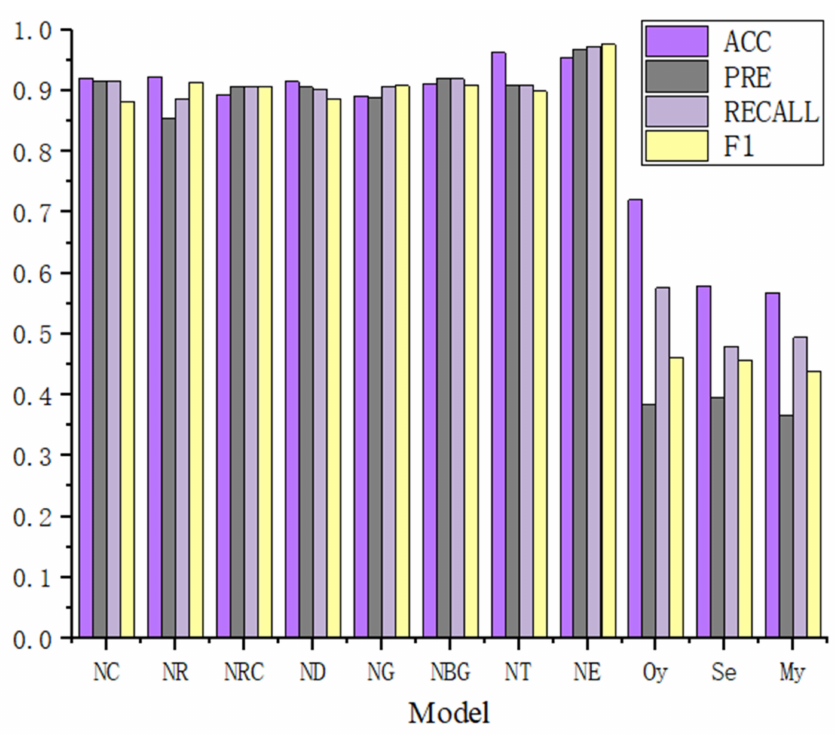
Figure 9. Model performance